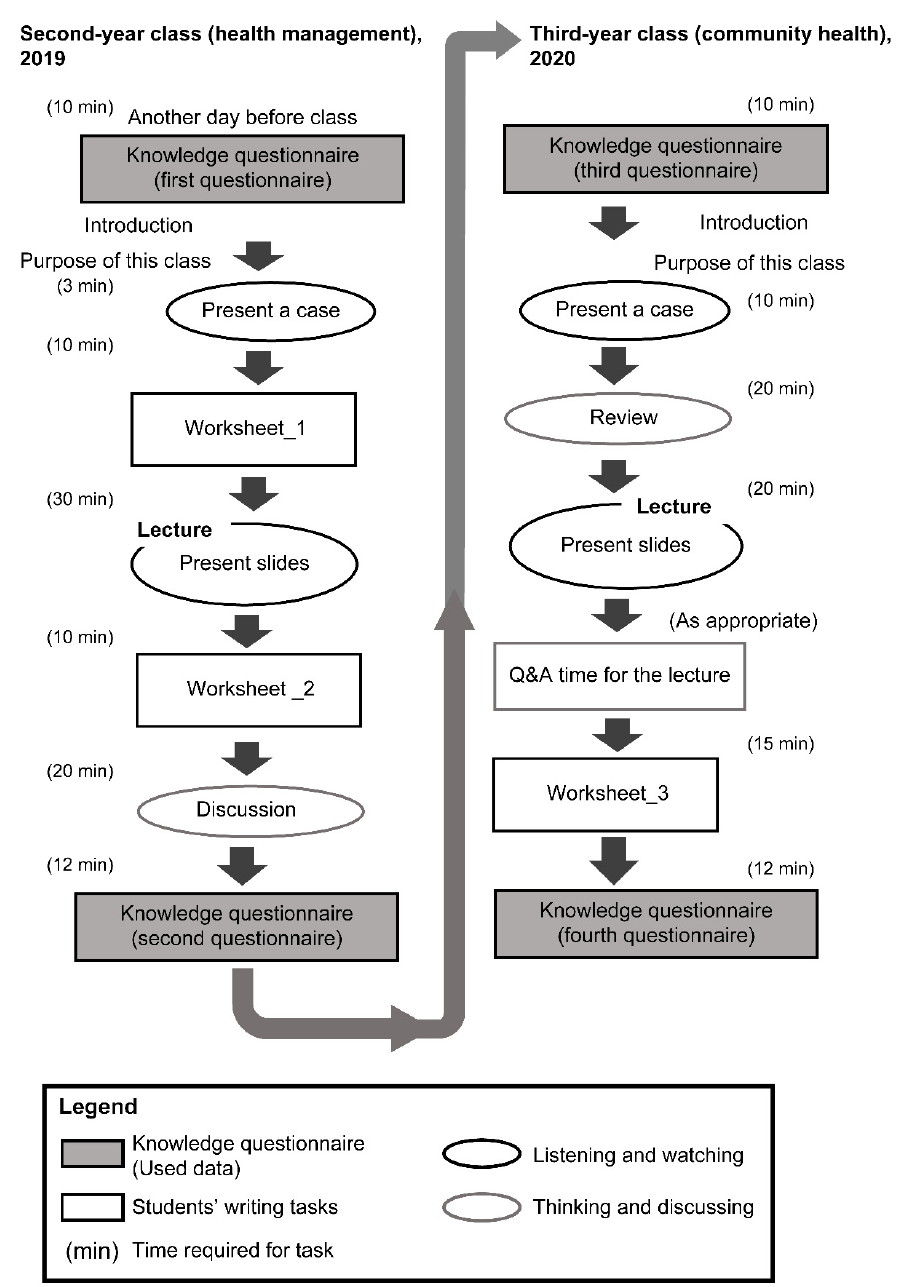
Figure 1. The flow of two classes over an interval of one year. The white boxes indicate students’ writing tasks. The gray boxes represent the analyzed data. The time required for each task is shown in parentheses.